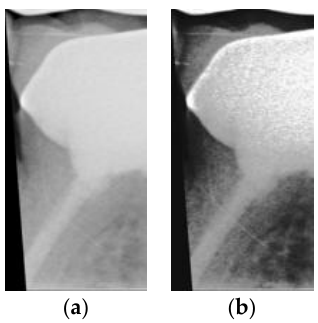
Figure 7. ( a ) Photo before image enhancement; ( b ) photo after image